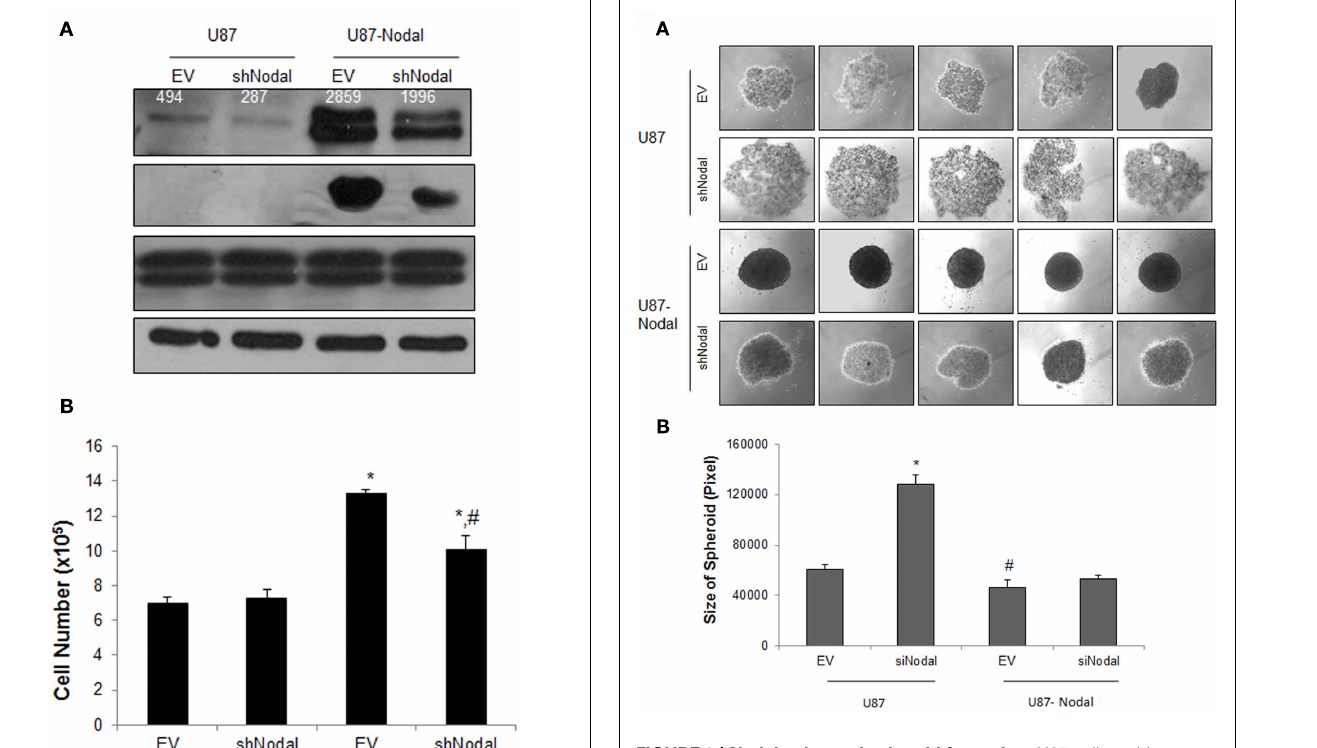
FIGURE 3 | Nodal enhanced spheroid formation. U87 cells stably transfected with Nodal and/or Nodal shRNA were cultured in hanging drops and formation of spheroids was observed at the forth day after culture. (A) Photographs of representative spheroids from each cell lines. (B) Quantifications of spheroid area. Data represent mean ± SEM ( n > 35 each group), * P < 0.001 vs. the other groups.This experiment was performed three times with similar